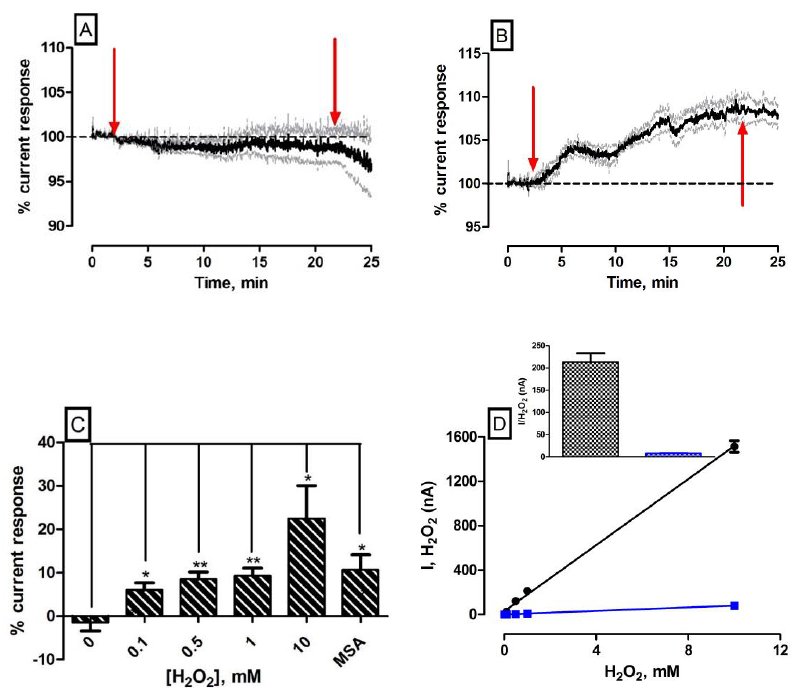
Figure 3. Averaged raw data percentage response of subtracted current from H 2 O 2 biosensor co-implanted with a microdialysis probe in the striatum of anaesthetised NOD SCID mice ( n = 4) to: ( A ) perfusion of artificial cerebrospinal fluid (aCSF); and ( B ) retroperfusion of 1 mM H 2 O 2 /aCSF. Red arrows indicate start/end of 20-min perfusion. Mean percentage current response represented by black trace, percentage error represented by grey trace. ( C ) Dose effect of retrodialysis of 0–10 mM H 2 O 2 /aCSF ( n = 4) and 1 mM mercaptosuccinic acid (MSA)/aCSF ( n = 3) on subtracted H 2 O 2 current. Percentage current response data represented as mean ± SEM. ( D ) In vitro current concentration profiles for extended H 2 O 2 calibration (0–10 mM) on H 2 O 2 blank electrode ( n = 4, r 2 = 0.99, black trace) and catalase electrode ( n = 3, r 2 = 0.99, blue trace). Inset: Comparison of average currents for both electrodes at 1 mM H 2 O 2 . All concentration profile data is presented as mean ± SEM. * denotes level of significance.